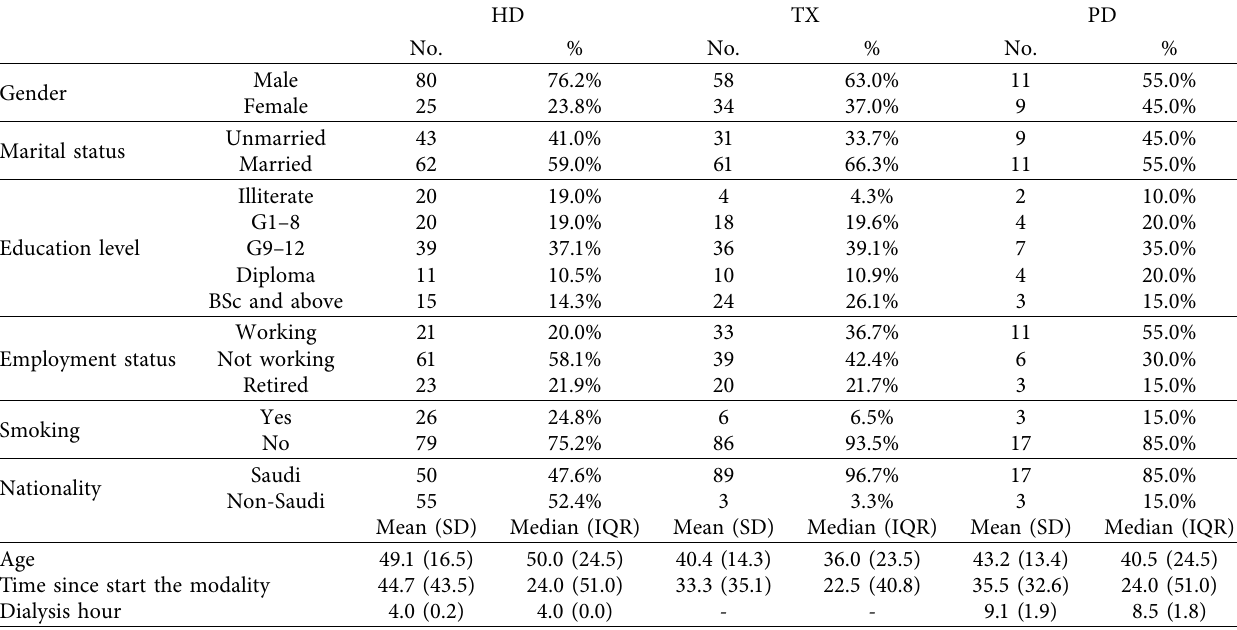
Table 1: Demographic characteristics of